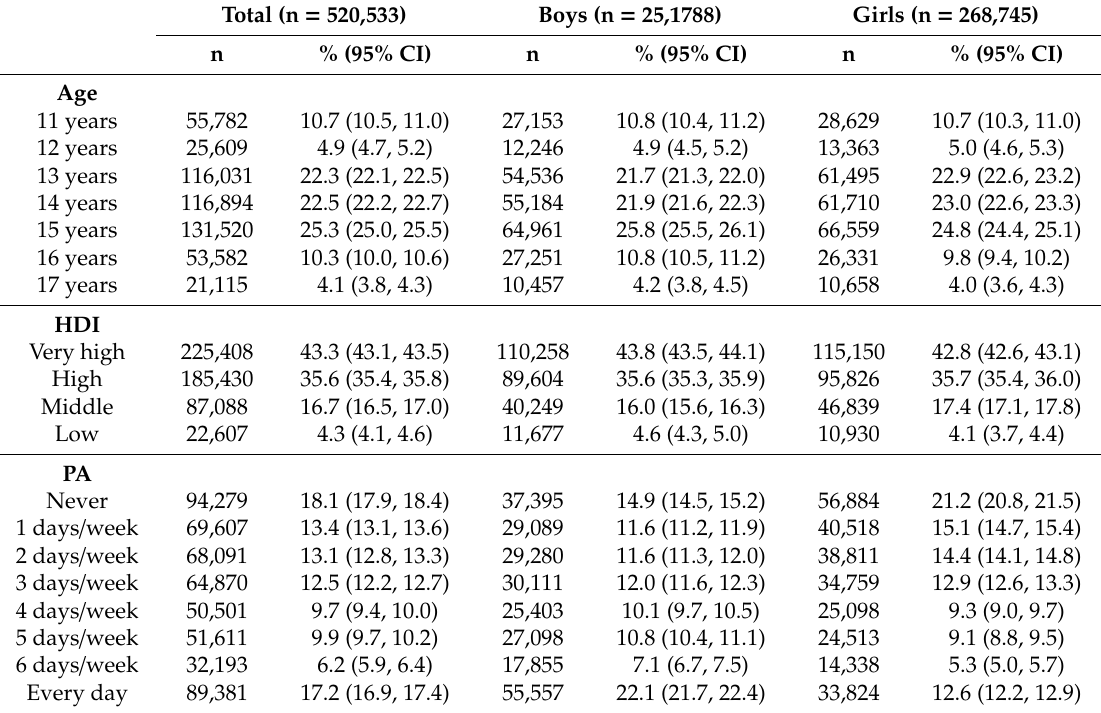
Table 1. Participants’